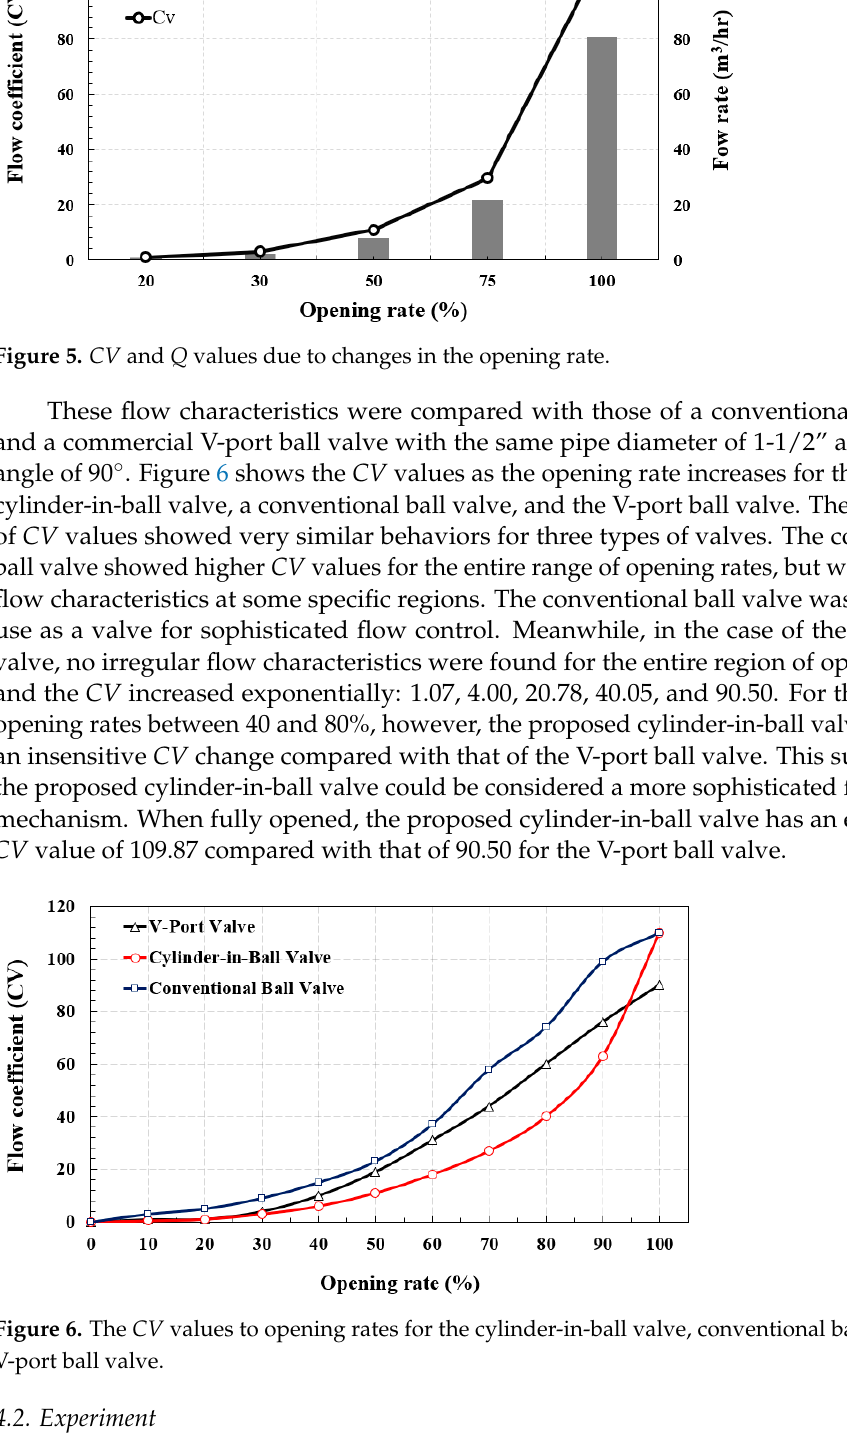
Figure 4. Streamlines at an opening rate of 20% for the cylinder-in-ball valve.